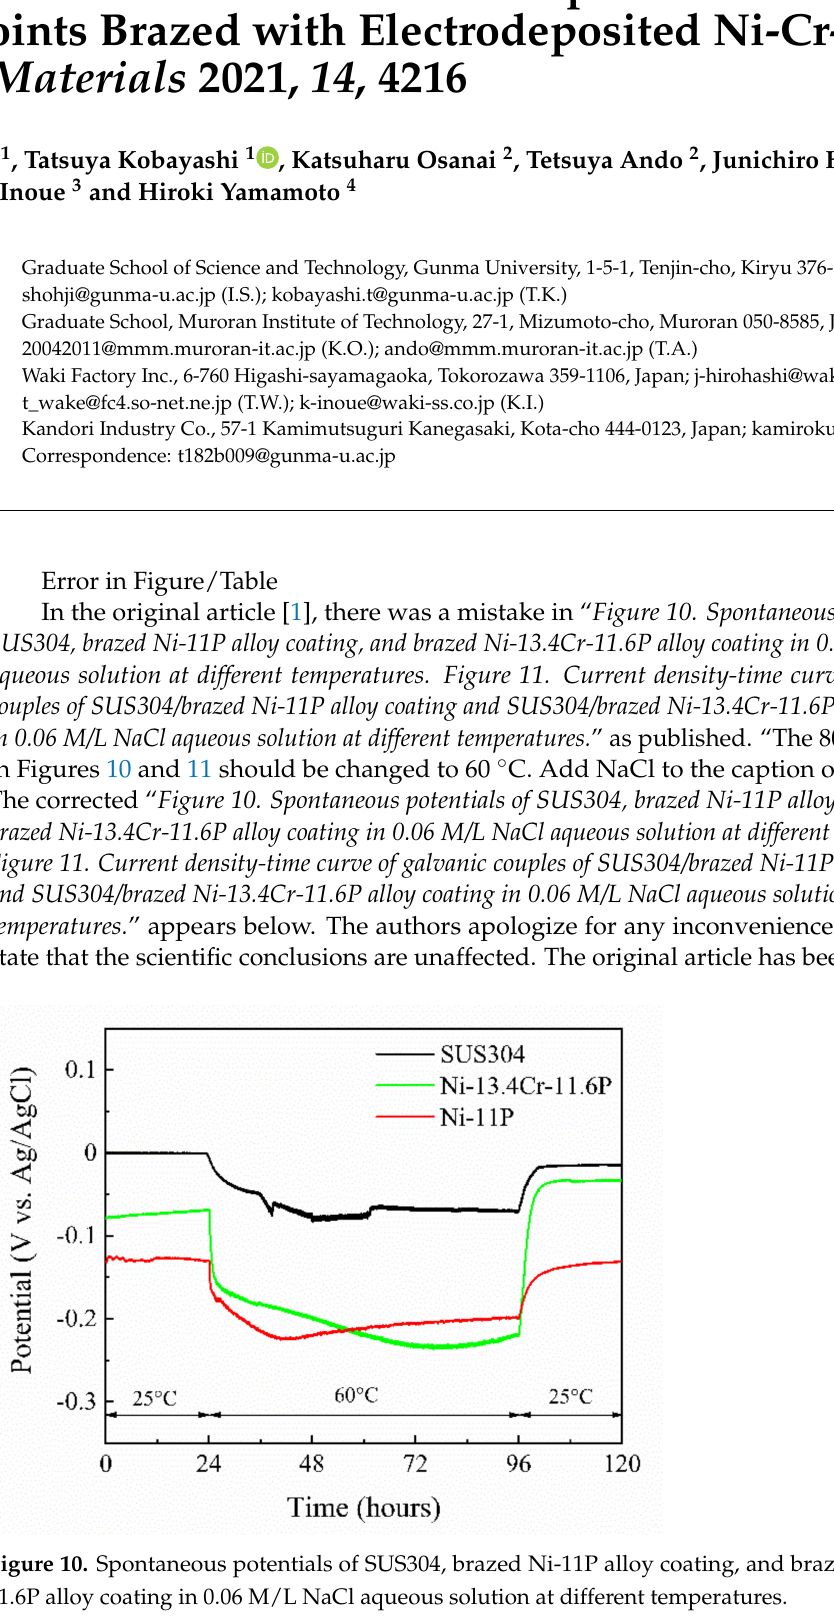
Figure 10. Spontaneous potentials of SUS304, brazed Ni-11P alloy coating, and brazed Ni-13.4Cr- 11.6P alloy coating in 0.06 M/L NaCl aqueous solution at different